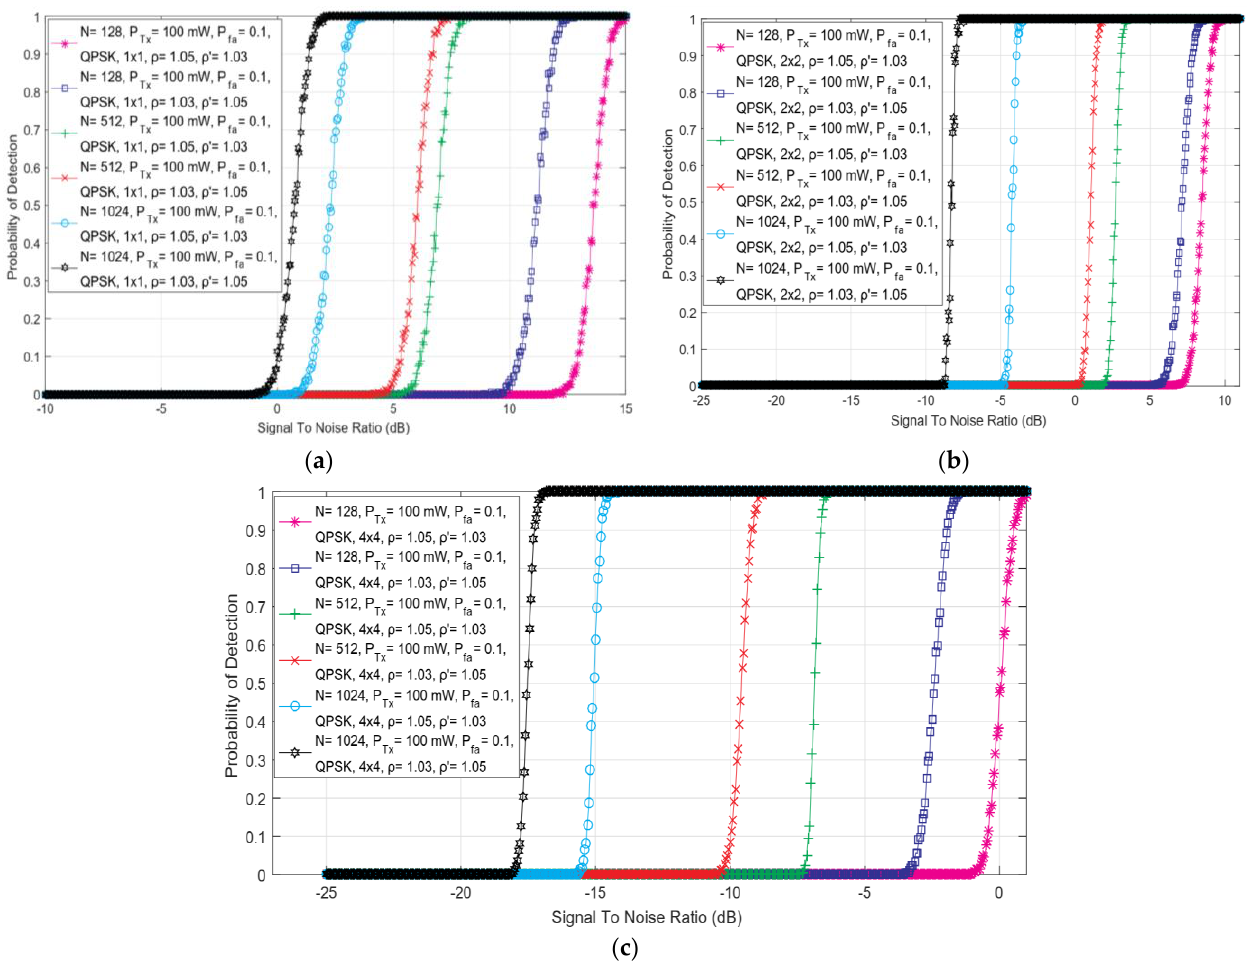
Figure 7. The dependency of the probability of detection on SNR for ED performed with the versatile number of sampling points and combinations of DDT and NU factors in ( a ) SISO, ( b ) 2 × 2 symmetric MIMO and ( c ) 4 × 4 symmetric MIMO communication